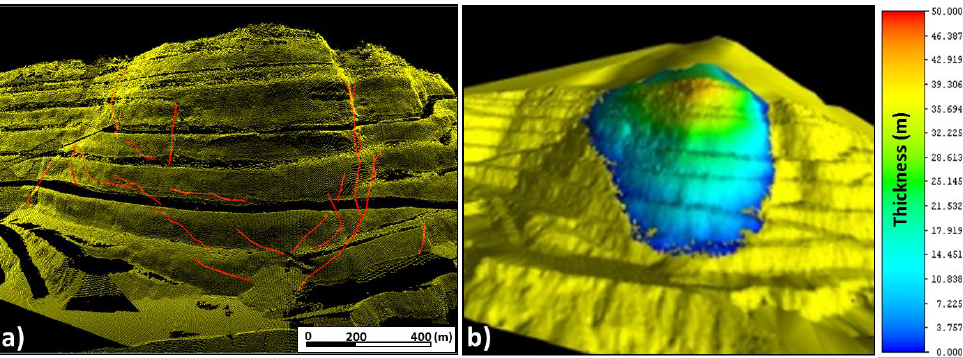
Figure 8. 3D maps of the investigated quarry sector: ( a ) fracture pattern traced on terrestrial laser scanning (TLS) point cloud; ( b ) thickness of the potentially unstable wedge on high resolution surface.